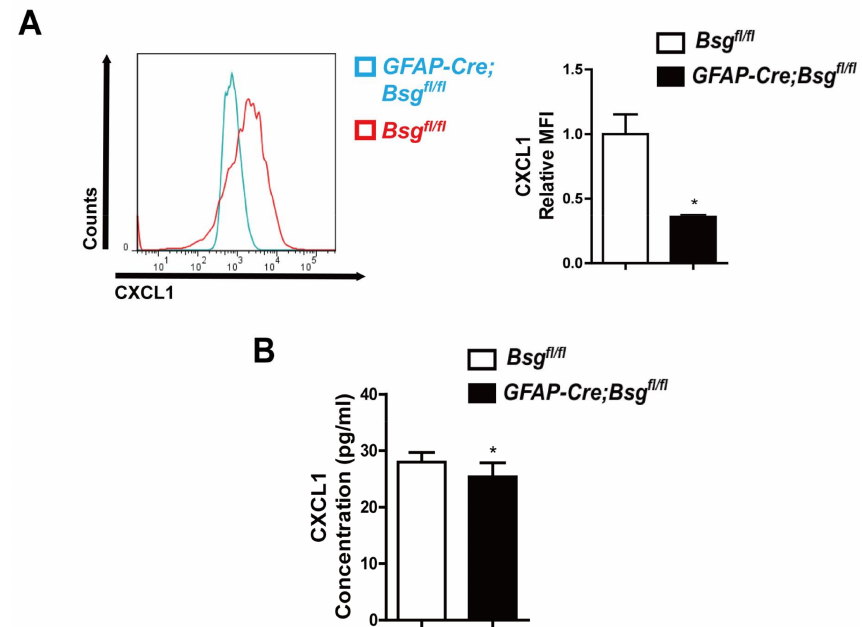
Figure 5. HSCs-specific deletion of CD147 deregulated CXCL1 expression. ( A ) Fluorescence activated cell sorting (FACS) analysis of CXCL1 expression in primary HSCs isolated from Bsg fl/fl and GFAP-Cre;Bsg fl/fl mice ( n = 3); ( B ) Enzyme-linked immunosorbent assay (ELISA) detection of serum CXCL1 in CCl 4 -induced Bsg fl/fl and GFAP-Cre;Bsg fl/fl mice (eight weeks, n = 4). The results were shown as the mean ± SD. * p <